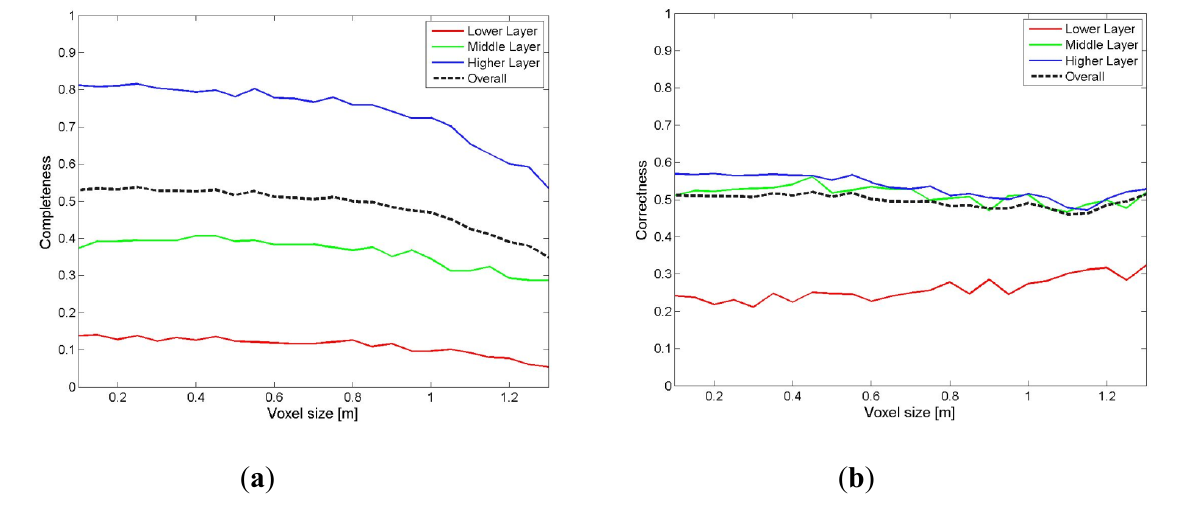
Figure 7. Sensitivity analysis with respect to the parameter acquired under leaf-on condition; ( a ) Completeness; ( b ) Correctness; colored lines indicate the forest layers.